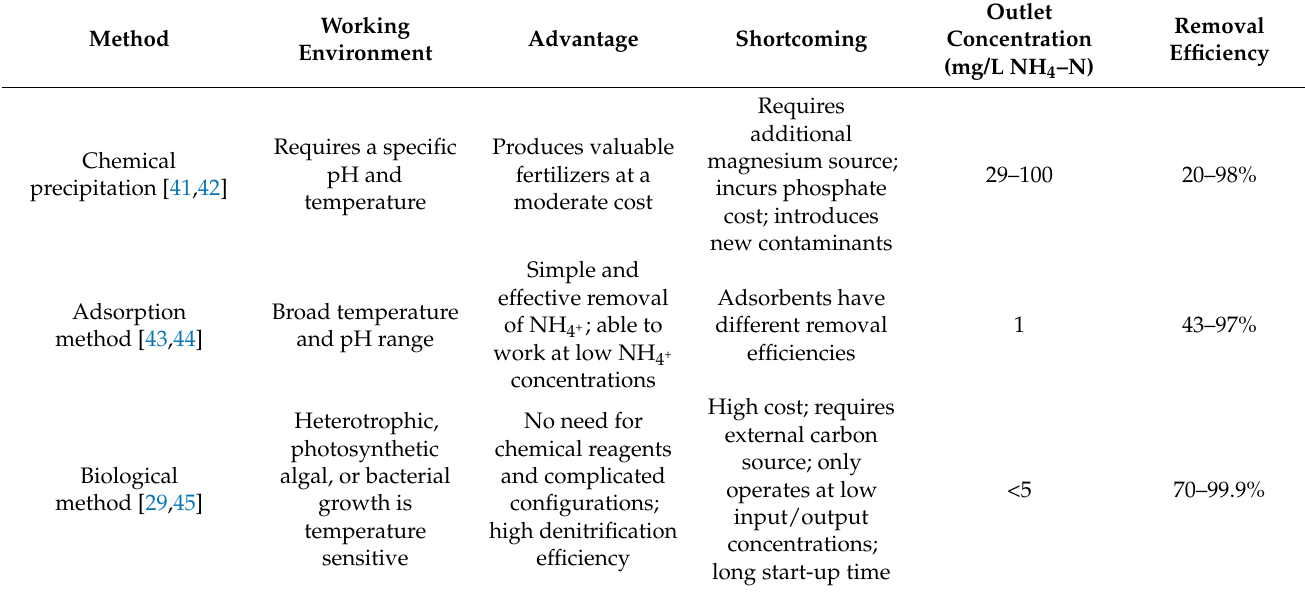
Table 1. Standard technologies for removing NH 3 /NH 4 + from